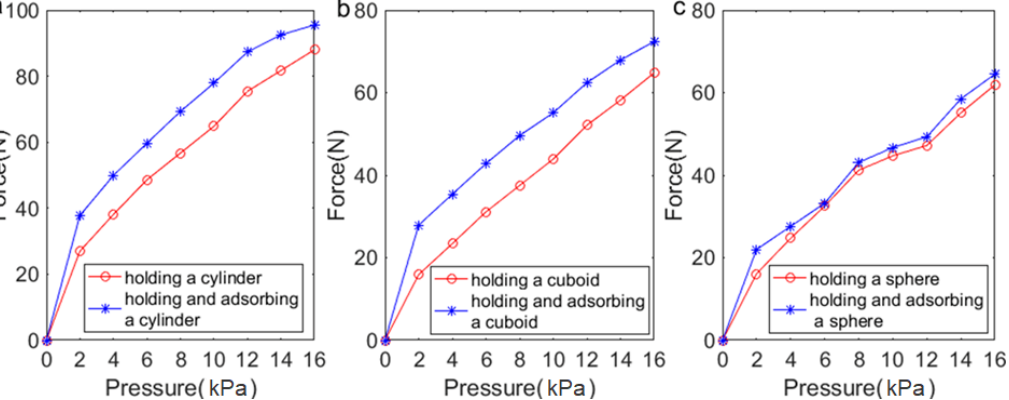
Figure 12. The red curves denote the maximum pulling forces of the cylindrical soft actuator that grasped experimental objects. The blue curves denote the maximum pulling forces of the cylindrical soft actuator and the detachable sucker acted on experimental objects, simultaneously. ( a ) A cylinder with diameter 60 mm. ( b ) A cuboid with diameter 60 mm. ( c ) A sphere with diameter 60 mm.